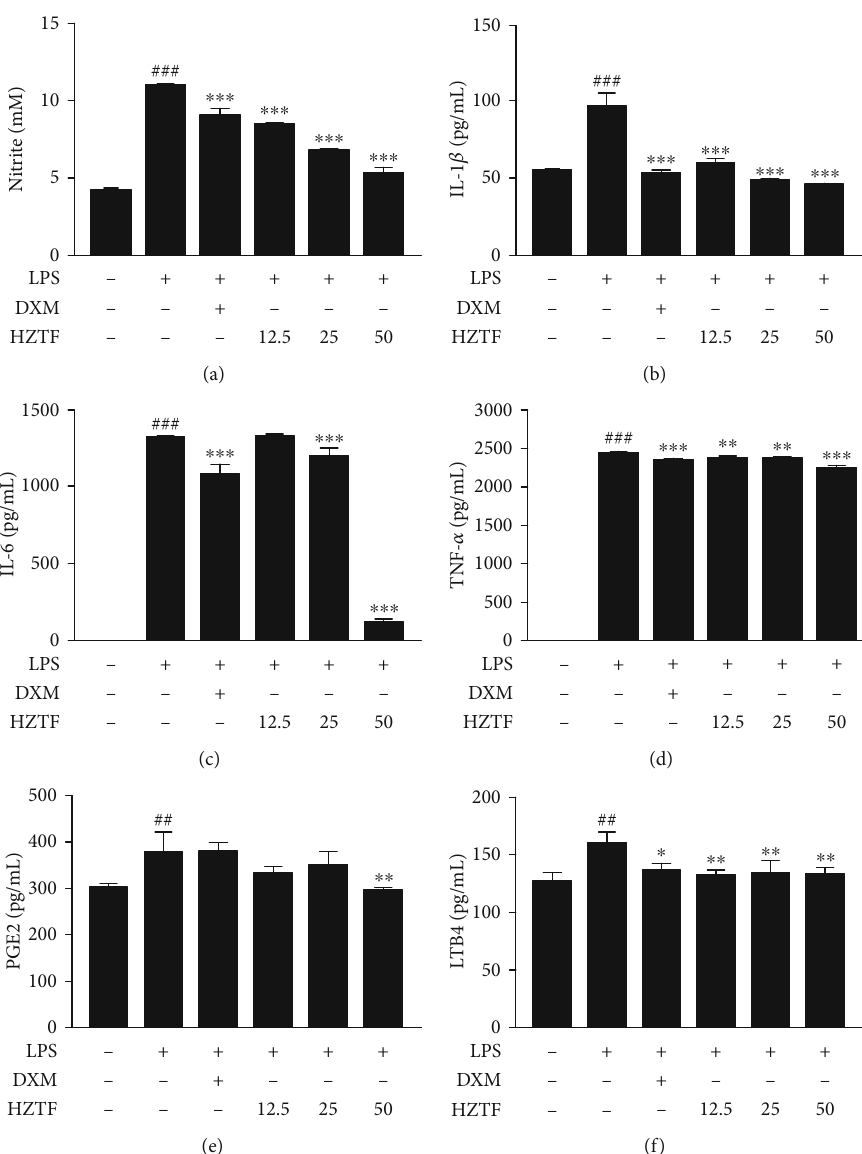
Figure 7: E ff ects of HZTF on the production of IL-1 β , IL-6, TNF- α , PGE2, and LTB4 in RAW264.7 cells under stimulation of LPS. RAW264.7 cells were pretreated with HZTF for 1 h and then induced with LPS (100ng/mL) for 24h. The concentration of NO (a) was determined by the Griess assay. (b) IL-1 β , (c) IL-6, (d) TNF- α , (e) PGE2, and (f) LTB4 level in the cell culture supernatant were quanti fi ed using an ELISA kit. The data were presented as means ± SD ( n = 3 ). ## P < 0 : 01 , ### P < 0 : 001 compared with the control group; ∗ P < 0 : 05 , ∗∗ P < 0 : 01 , and ∗∗∗ P < 0 : 001 versus the LPS